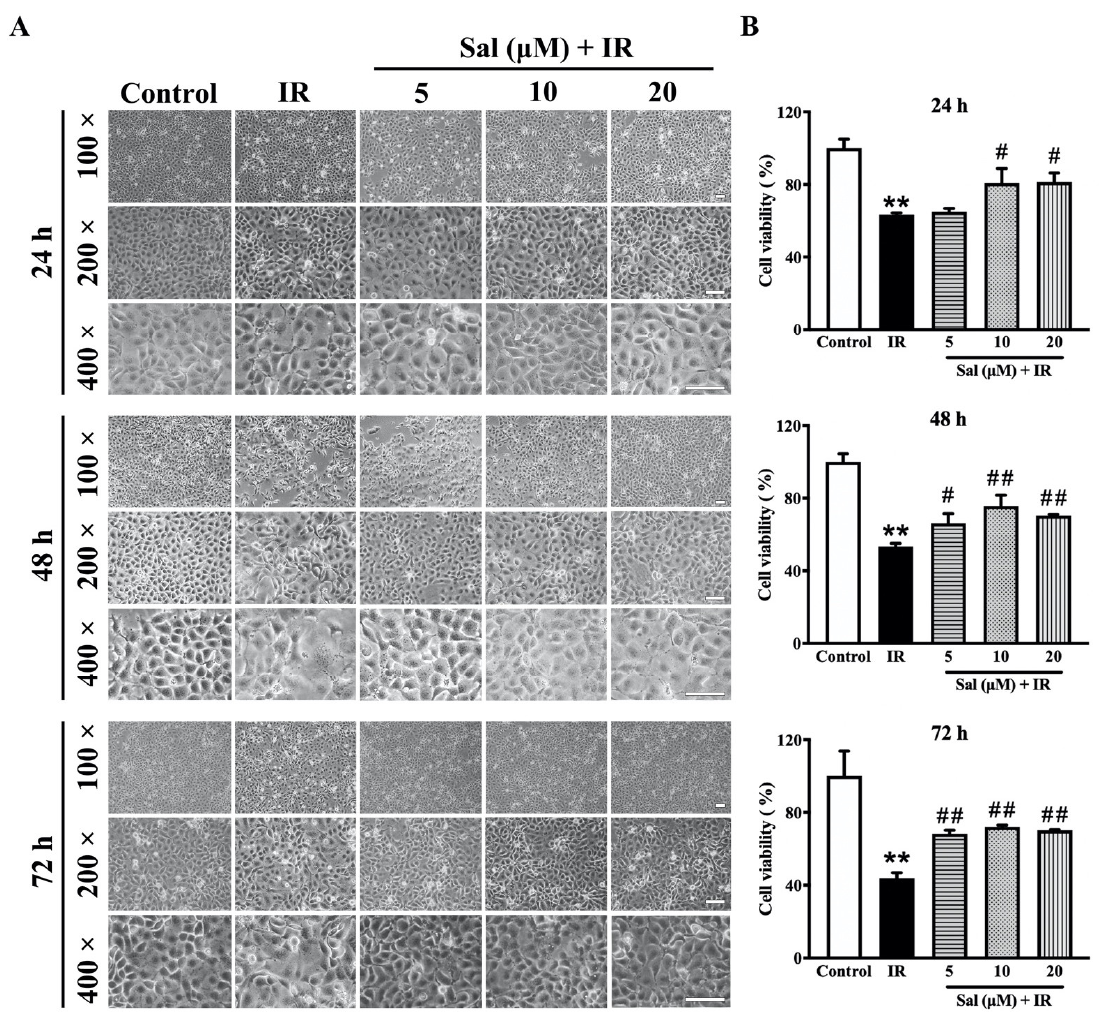
Figure 1. Salidroside mitigated radiation damage in SMG cells. SMG-C6 cells were used in ( A ) and ( B ). SMG-C6 cells were pretreated with salidroside (5, 10, or 20 μM) for 24 h before exposure to 15 Gy X-ray and tested at 24, 48, and 72 h after irradiation, respectively. ( A ) Representative images of SMG-C6 cells were obtained by an inverted microscope (bar = 100 μm). ( B ) Cell viability was detected with a CCK-8 assay. The data are presented as the mean ± SEM from 3 independent experiments, with each sample analyzed in triplicate. ** p < 0.01 vs. the control; # p < 0.05 and ## p < 0.01 vs. irradiation alone.